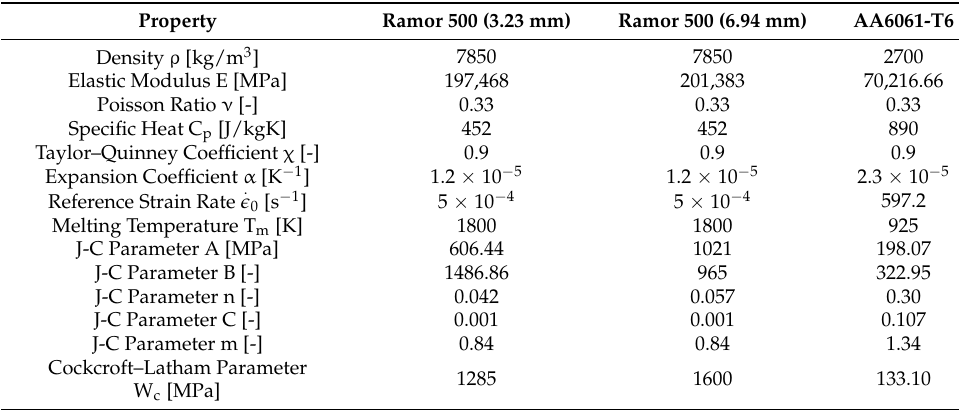
Table 5. Target materials input parameters